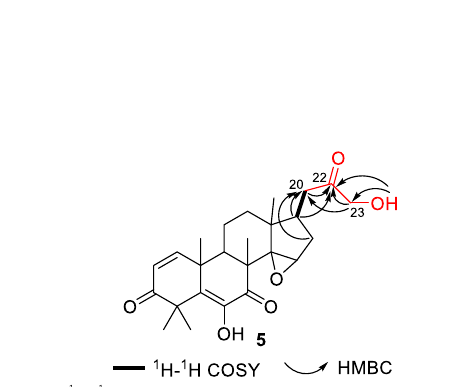
Fig. 2 Key 1 H– 1 H COSY and HMBC (H